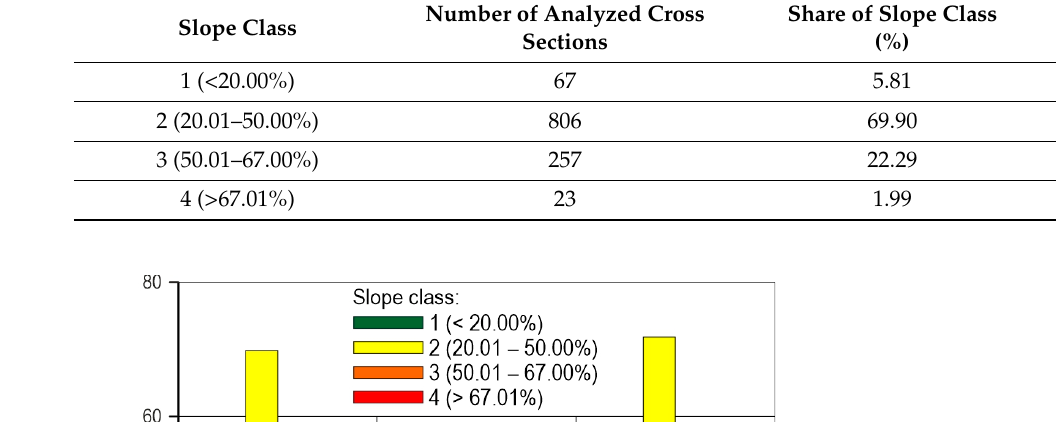
text represent values graphically shown in Figure 2.